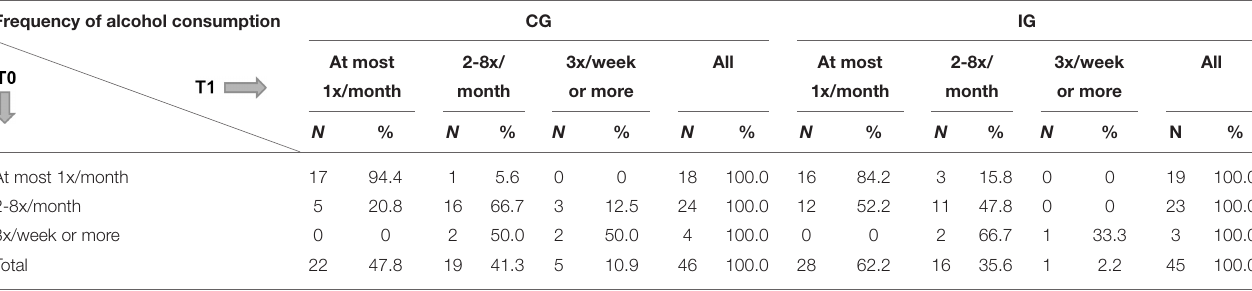
TABLE 6 | Frequency of alcohol consumption at baseline and follow-up among individuals overestimating peer use at baseline and correctly or underestimating use at follow-up (CG: n = 46, IG: n = 45).